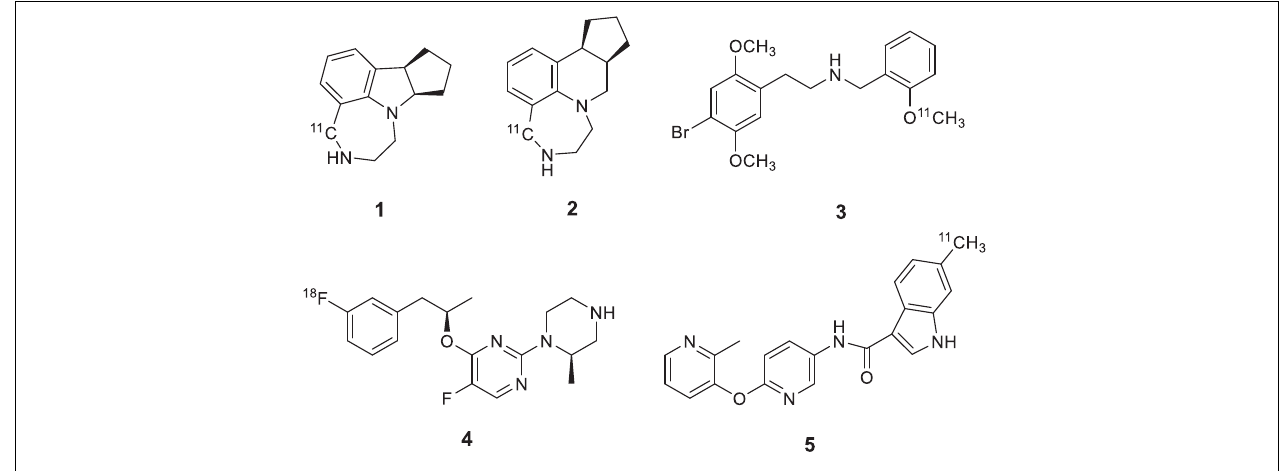
FIGURE 1 | Chemical structures of reported PET imaging agents for 5-HT 2 C R.